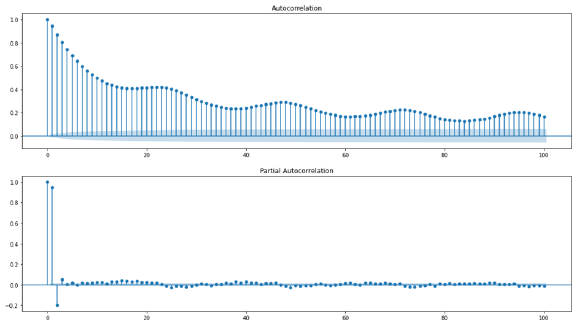
Fig. 4. ACF and PACF of Basel’s wind speed.